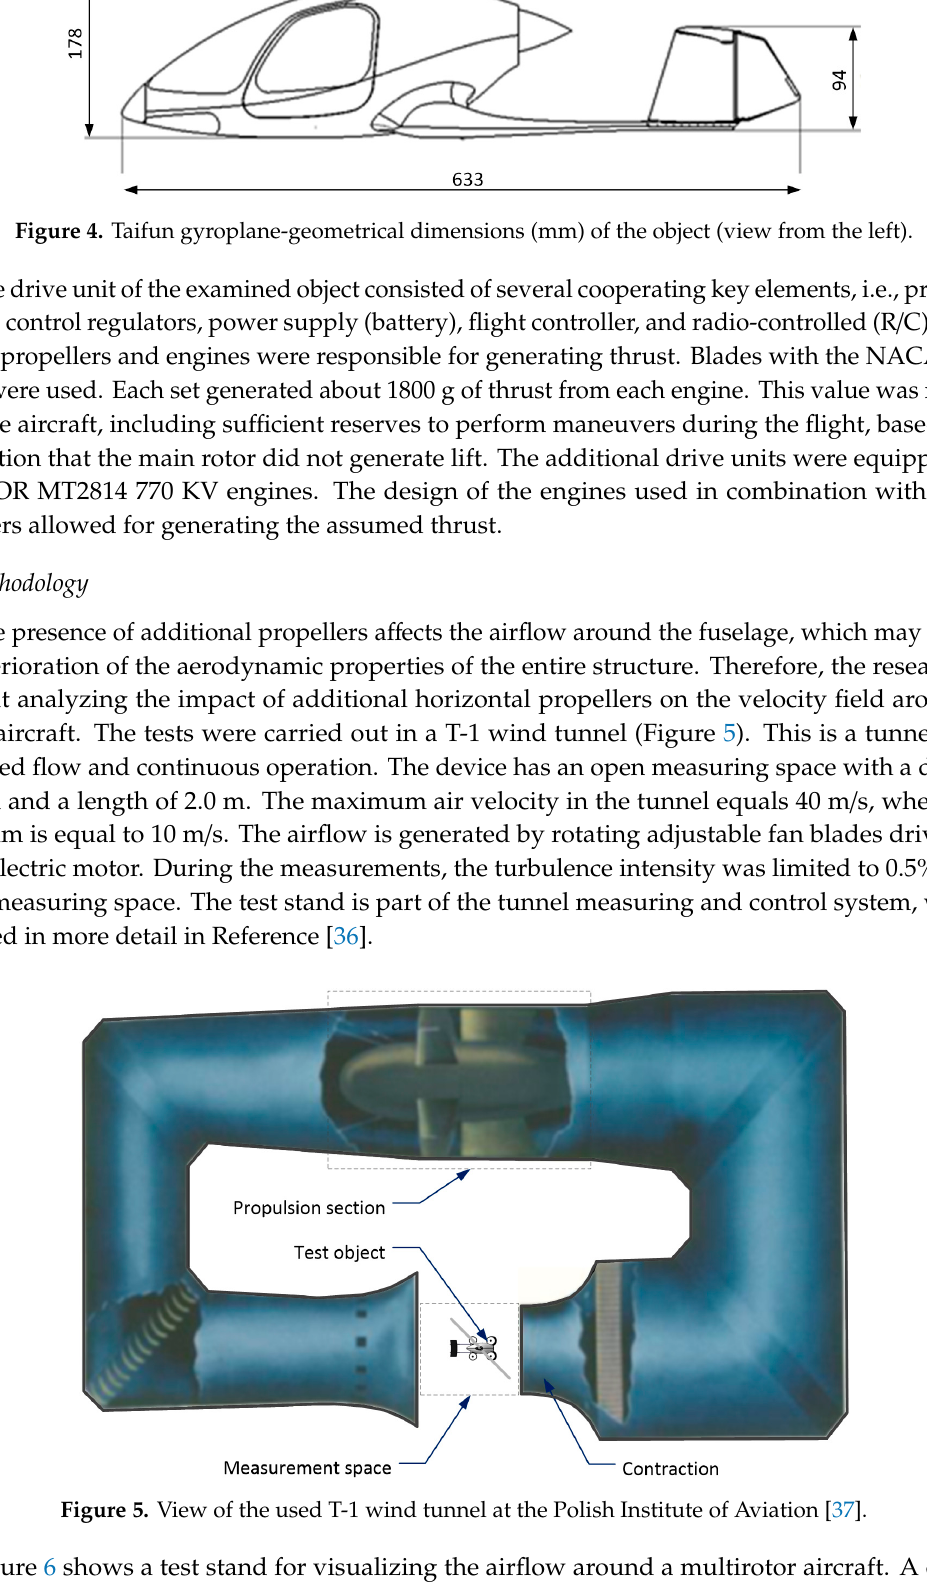
Figure 3. Geometric dimensions (mm) of the test object (front view).